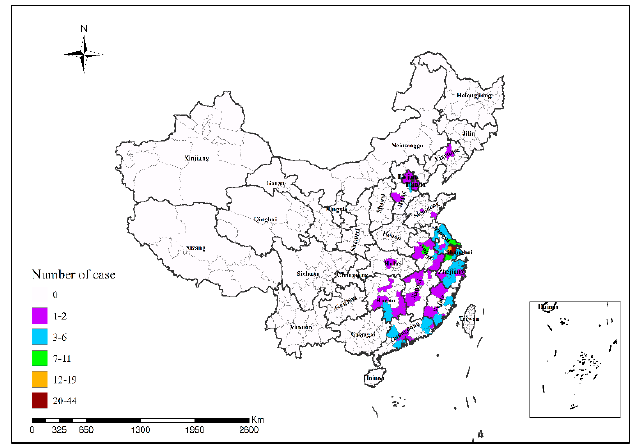
Figure 5. Spatial pattern of H7N9 outbreaks in China in 2016.